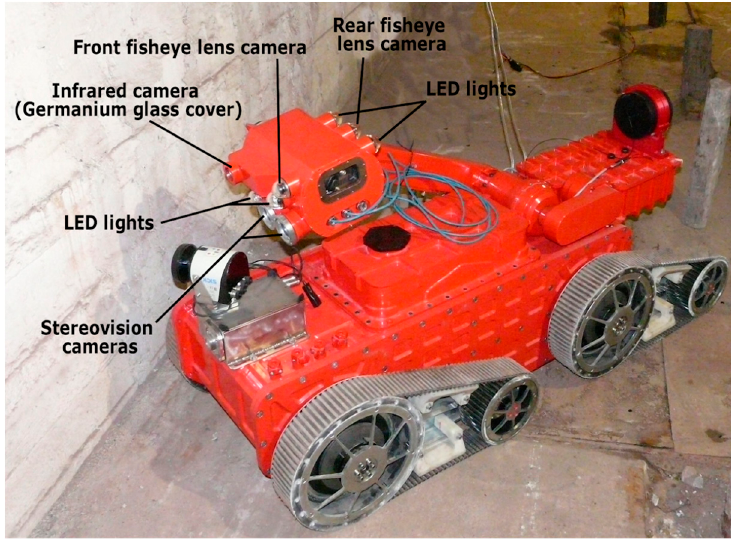
Figure 5. TeleRescuer—cameras and lights on the sensory head.